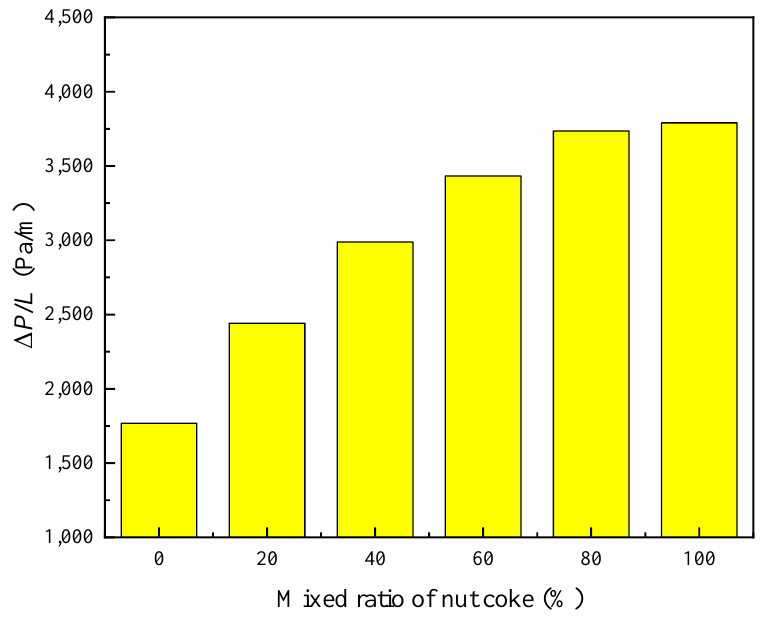
Figure 17. Pressure drop comparison with different mixed ratios of nut coke.